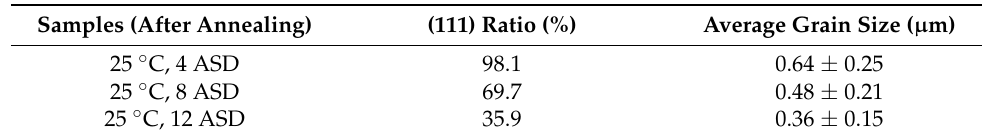
Table 2. Degree of (111) orientation and grain size of the nt-Cu films deposited at 25 ◦ C and annealed at 200 ◦ C for 10 h.